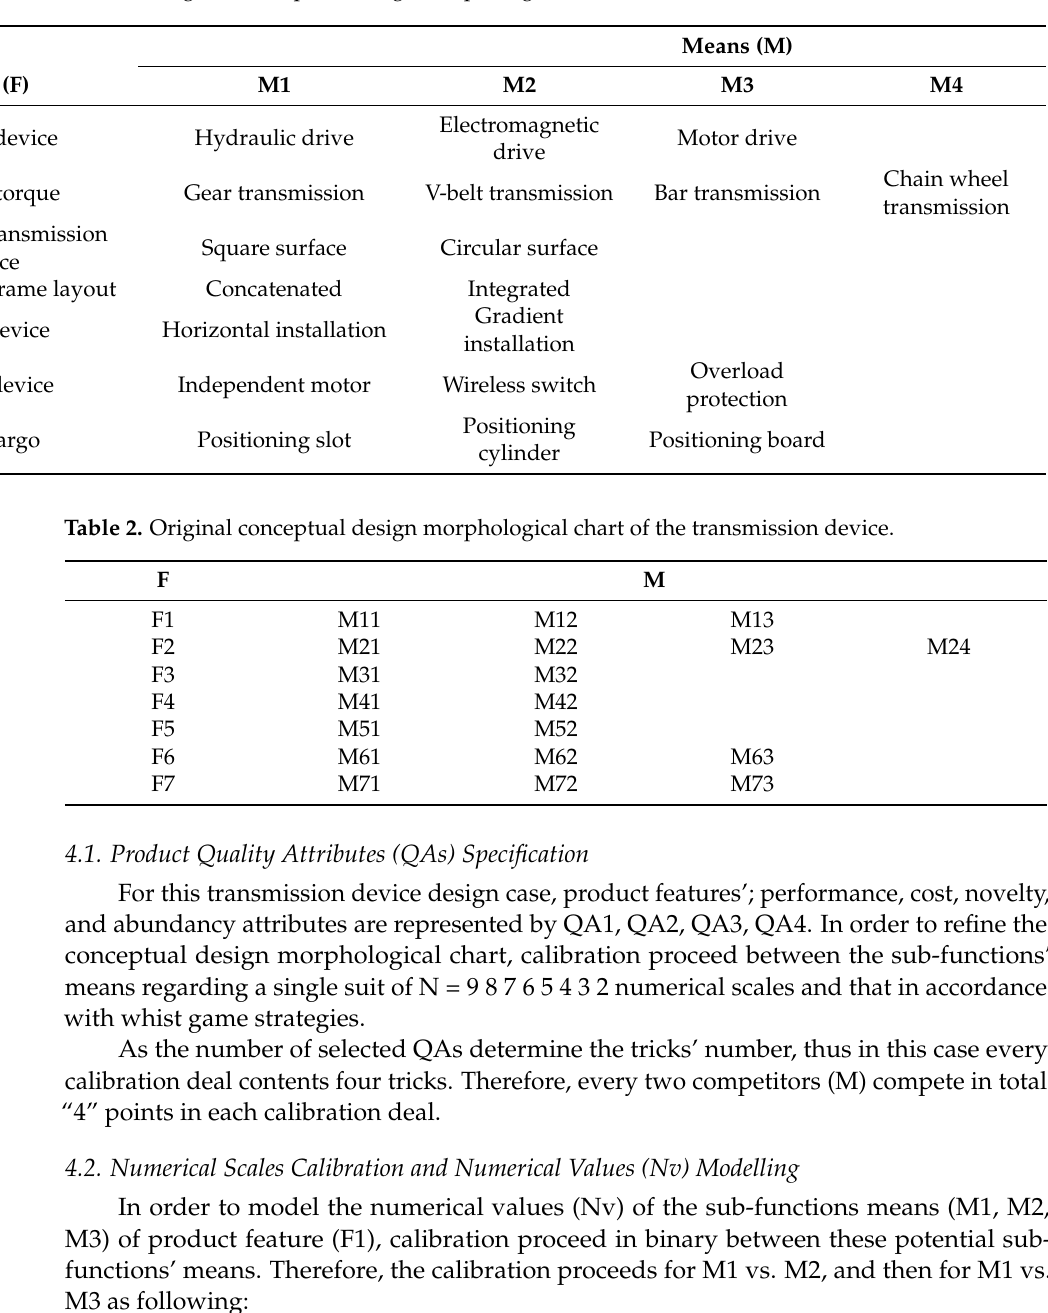
Table 1. Original conceptual design morphological chart of the transmission device.